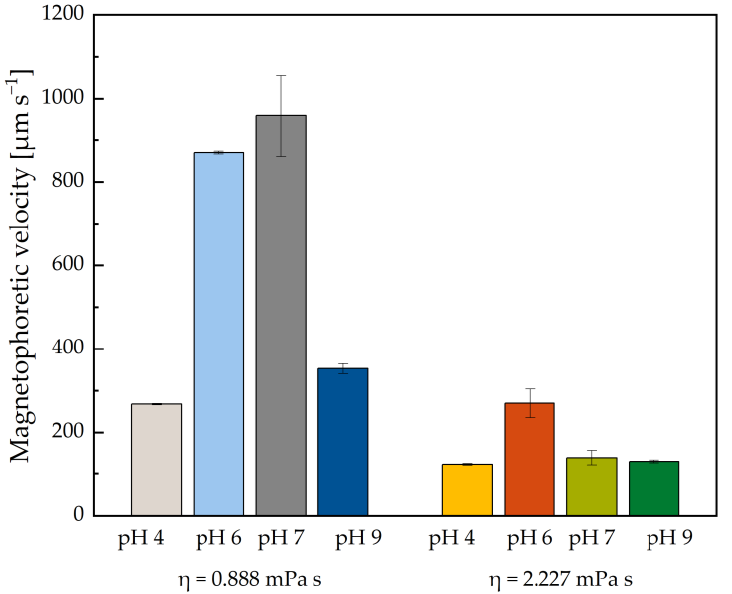
Figure 4. Magnetophoretic velocity over pH 4, 6, 7, and 9 of BION suspension in deionized water (η = 0.888 mPa s) and sucrose solution (η = 2.227 mPa s) with a corresponding mean diameter of DLS measurement.